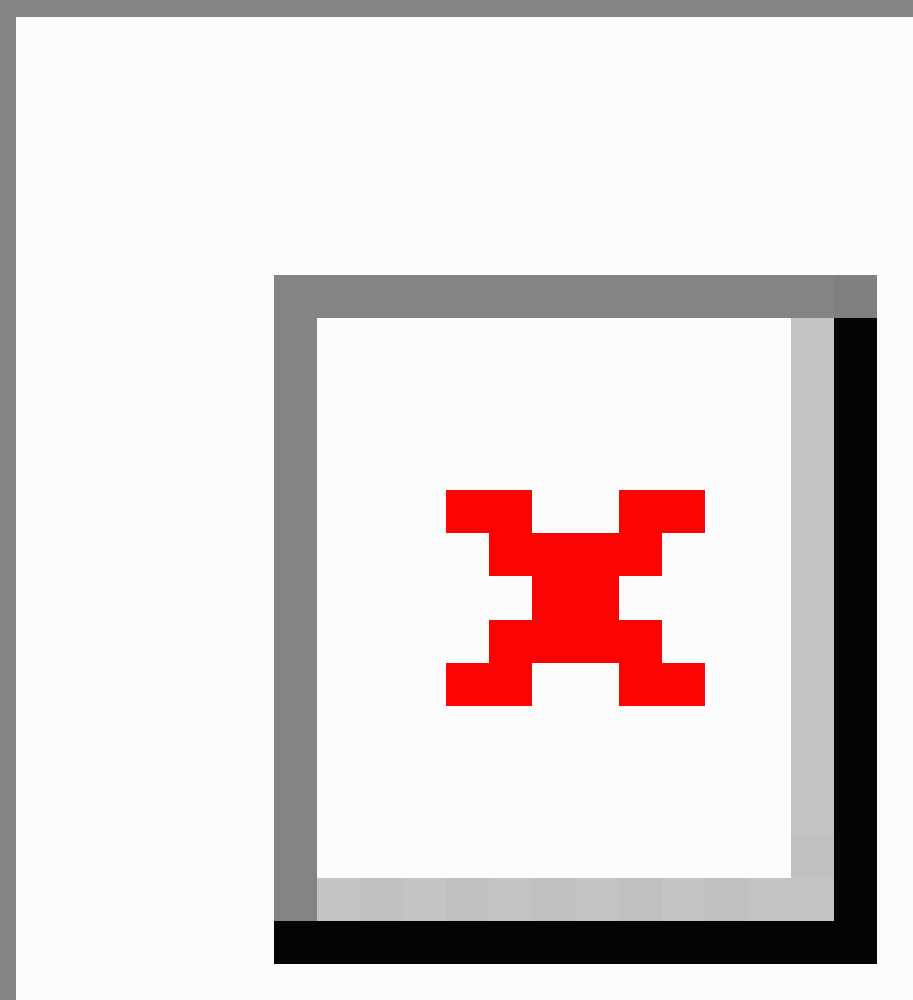
Figure 6. The role of mHealth in high, middle, and low income